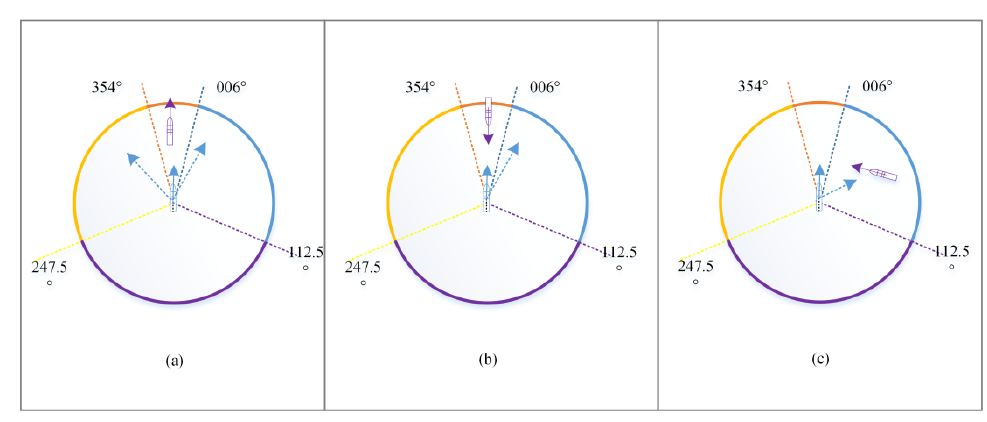
Figure 7. Decisions in different encountering situations: ( a ) Overtaking situation; ( b ) Head-on situation; ( c ) cross situation.